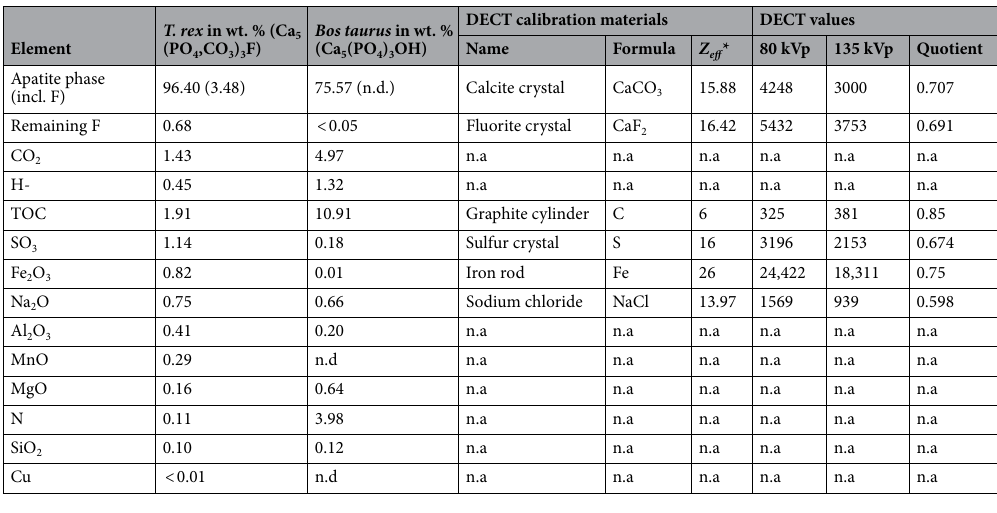
Table 1. Relevant elements detected in the Tyrannosaurus rex haemal arch and Bos taurus leg bone and their DECT characteristics. The effective atomic number (Z eff ) was calculated by a professional chemist. n.d. not detectable, n.a. not